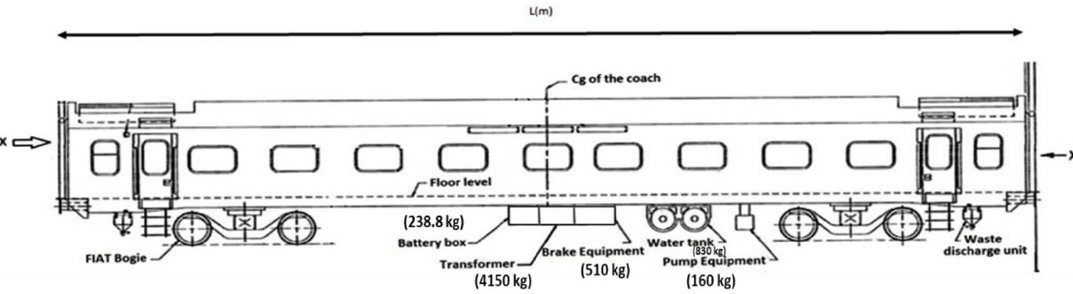
Figure 2. Schematic model of the passenger rail–vehicle with suspended equipment of LHB coach.